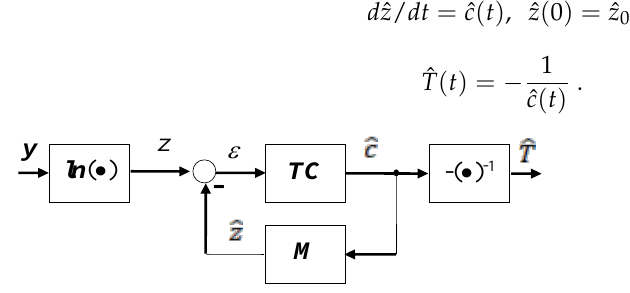
Figure 2. The structure of the parameter observer S o . The tracking